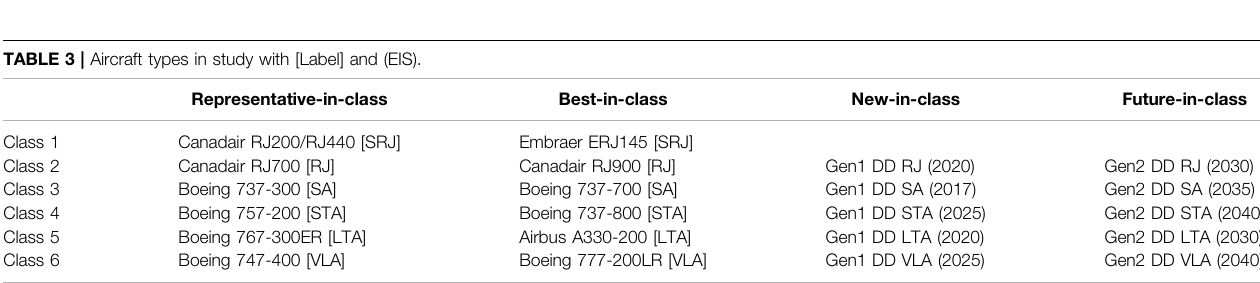
TABLE 3 | Aircraft types in study with [Label] and